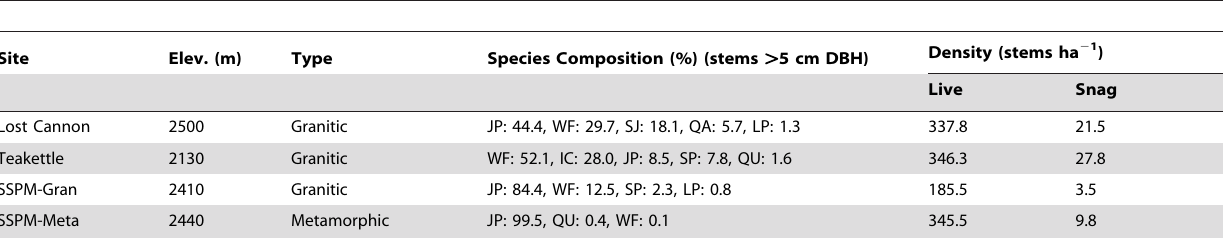
Table 1. Site and average forest characteristics from four old-growth Jeffrey pine-mixed conifer forests in the Sierra Nevada, California, and northwestern Mexico.